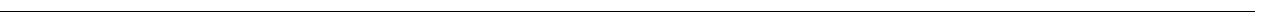
Fig. 5 HSP70 selectively escorts mutant Blimp-1 proteins to Hrd1. a 293T cells overexpressing fl ag-tagged WT or mutant Blimp-1 proteins were treated with MG132 or left untreated for 12 h. The interaction between Blimp-1- fl ag and endogenous HSP70 was analyzed with a co-IP assay. b HeLa cells co- expressing mCherry-HSP70 with GFP-tagged WT or mutant Blimp-1 proteins were treated with MG132 or left untreated for 12 h and observed under a confocal microscope. Scale bar : 10 μ m. c Hrd1 − / − 293T cells co-expressing fl ag-tagged WT or mutant Blimp-1 proteins with mCherry-Hrd1 and mCherry- HSP70 were treated with MG132 or left untreated for 12 h. The lysates were co-immunoprecipitated with an anti- fl ag antibody and then immunoblotted with antibodies against the indicated proteins. d Hrd1 − / − 293T cells co-expressing fl ag-tagged WT or mutant Blimp-1 proteins with myc-tagged HSP70 were treated with MG132 or left untreated for 12 h. The lysates were co-immunoprecipitated with an anti-myc antibody and then immunoblotted with antibodies against the indicated proteins. e Hrd1 − / − 293T cells co-expressing mCherry-Hrd1 with fl ag-tagged WT or mutant Blimp-1 proteins were treated with MG132 or VER155008 for 12 h. Then, the cell extracts were co-immunoprecipitated with an antibody against fl ag and immunoblotted with the antibodies as indicated. f HeLa cells overexpressing GFP-tagged mutant Blimp-1 proteins were treated with MG132, VER155008 or both for 12 h and then observed under a confocal microscope. Scale bar : 10 μ m. g 293T cells overexpressing fl ag-tagged WT or mutant Blimp-1 proteins were treated with VER155008 (10 μ M) or left untreated for 24 h. Total lysates were analyzed by western